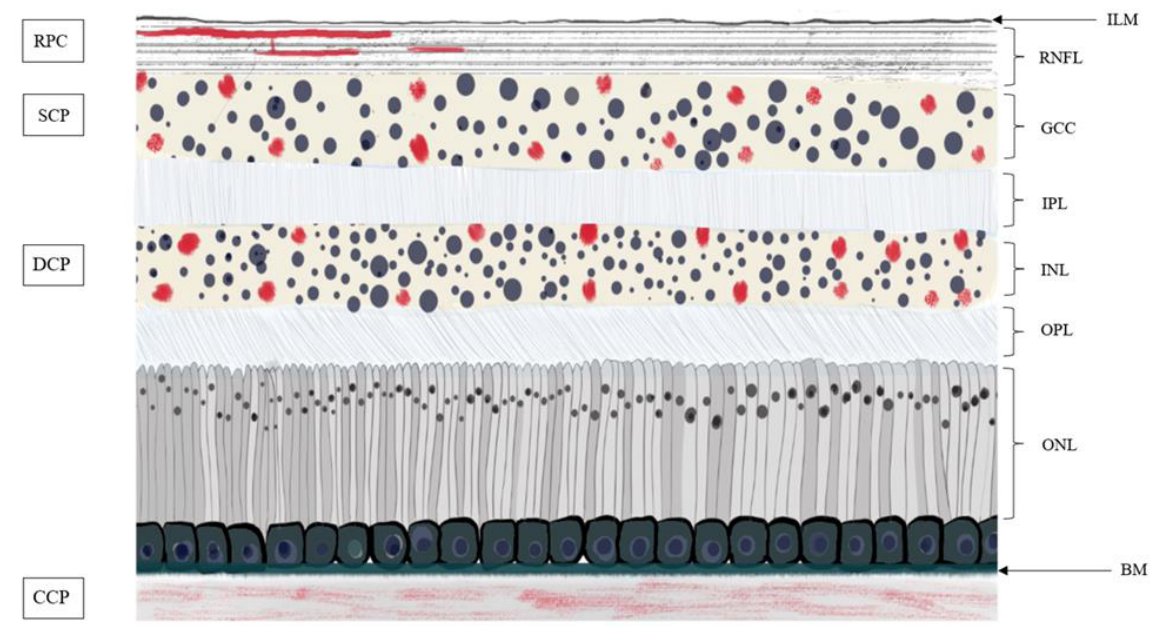
Figure 2. Drawing of vascular capillary plexus in retina. The capillaries are represented by red dots and the cell nuclei by dark blue dots. The RPC is arranged parallel to the nerve fibers. Abbreviations: BM—Bruch’s membrane; CCP—choriocapillaris plexus; DCP—deep capillary plexus; GCC—ganglion cell complex; ILM—inner limiting membrane; INL—inner nucleus layer; IPL—inner plexiform layer; ONL—outer nucleus layer; OPL—outer plexiform layer; RNFL—retinal nerve fiber layer; RPC—radial peripapillary capillaries; SCP–superficial capillary plexus.